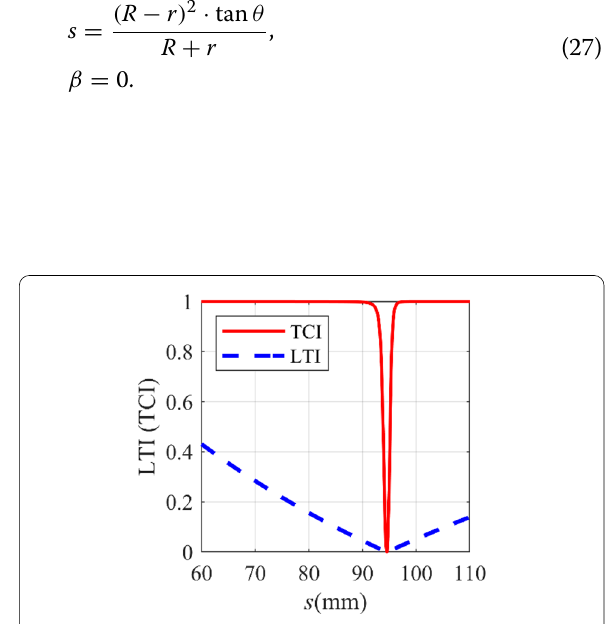
Figure 10 Relationship between TCI/LTI and